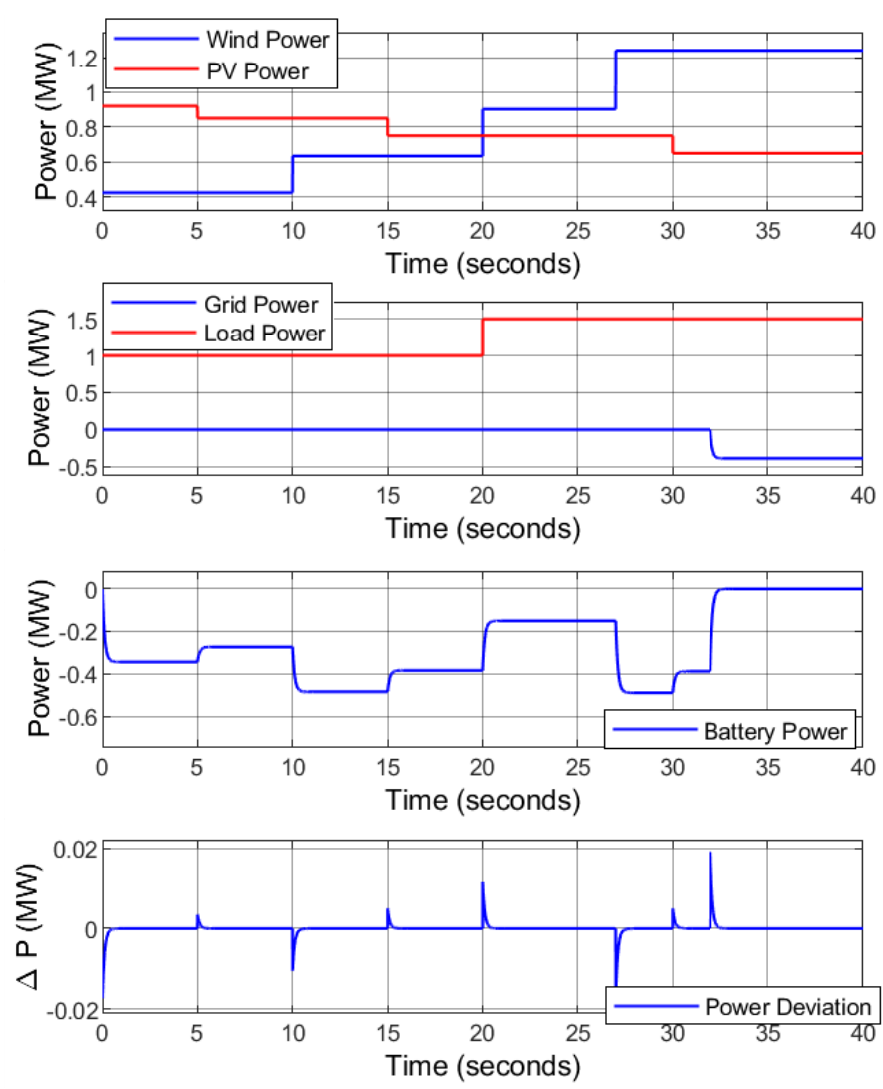
Figure 13. Scenario 3: power management of the